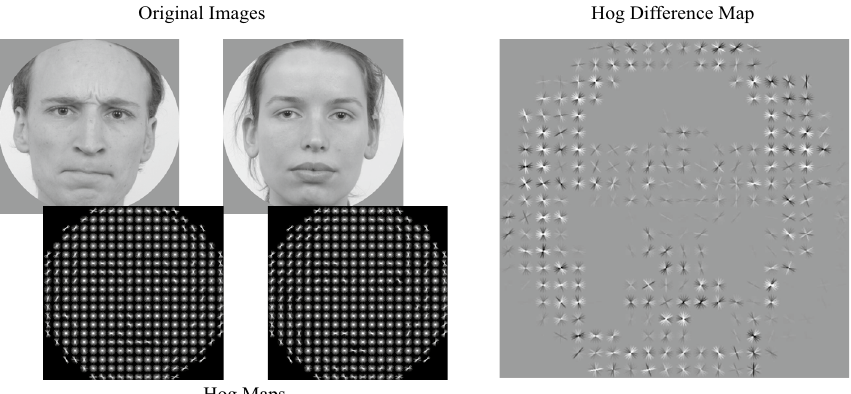
Figure 1. Visualisation of the Fourier feature extraction showing an example of two images used in a trial, their respective, down sampled Fourier features and the Fourier feature differences map. Note that in the Fourier Maps each location corresponds to a particular combination of a spatial frequency and an orientation. The Fourier maps are rotated 90° such that all have horizontal edge contrasts along the horizontal axes, and vertical edge contrast along the vertical axes. The radial axes are for cycles per image (abbreviated to cpi in the figure; ranging from low in the centre to high near the edges). Luminance intensity, from black to white, indicates the relative strength of the contrast for the corresponding section of the map. The Fourier feature differences map was calculated by subtracting the down sampled Fourier features of the image presented on the right, from those of the image on the left. Note that the feature difference map is scaled such that dark regions indicate negative values and light regions indicate positive values.